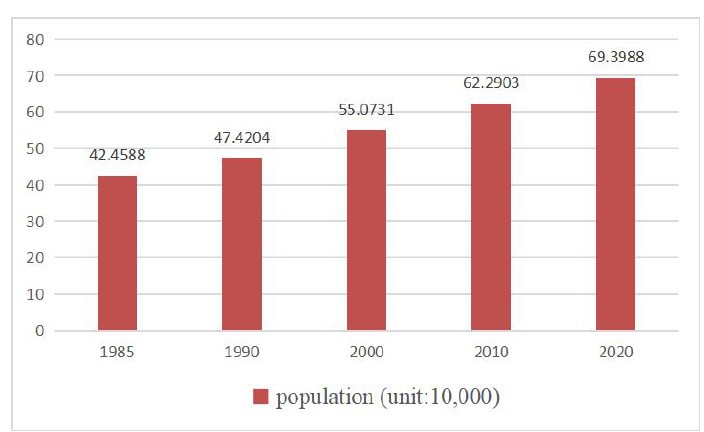
Figure 12. Population trend in Turpan City from 1985 to